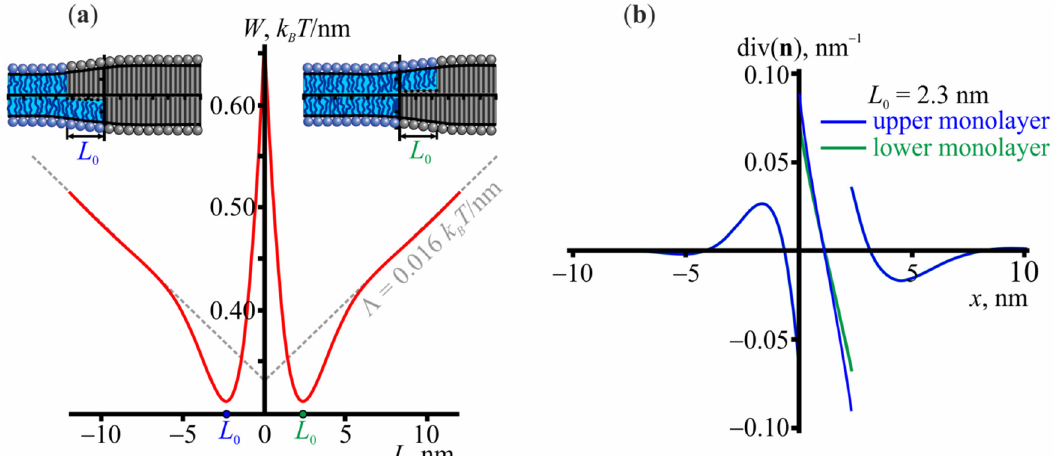
Figure 1. The structure of the L o /L d interface. ( a ) The dependence of the elastic energy on the relative shift L between the boundaries of ordered monolayer domains located in opposing membrane leaflets. The membrane shapes are shown in the insets for the cases of | L| ≈ 2.3 nm, which correspond to the energy minimum. ( b ) The lateral distribution of the effective curvature, i.e., the divergence of the director, at the domain boundary. Blue and green colors correspond to the upper and lower monolayer, respectively.